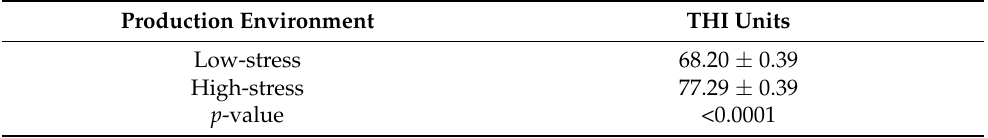
Table 2. Least square means of temperature-humidity index (THI) for the low- and high-stress dairy-production